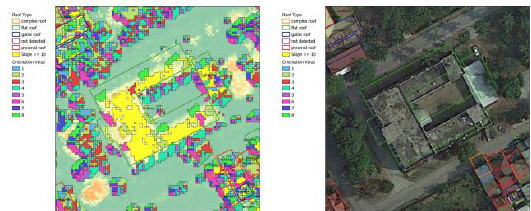
Figure 13. Flat roof building’s OSM building footprints overlaid on the aspect and slope map (left) and aerial photo (right).